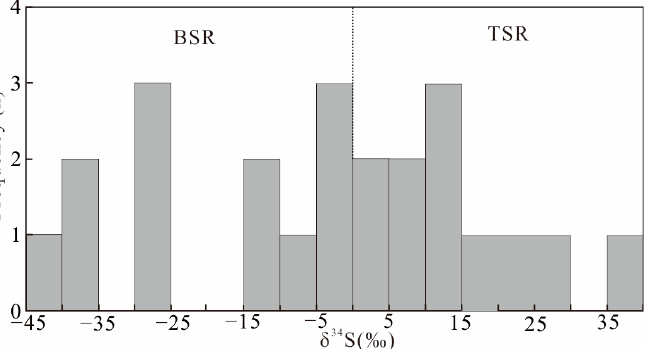
Figure 7. Histograms showing the distribution of δ 34 S values from different genetic pyrites in Qianjiadian ore field.